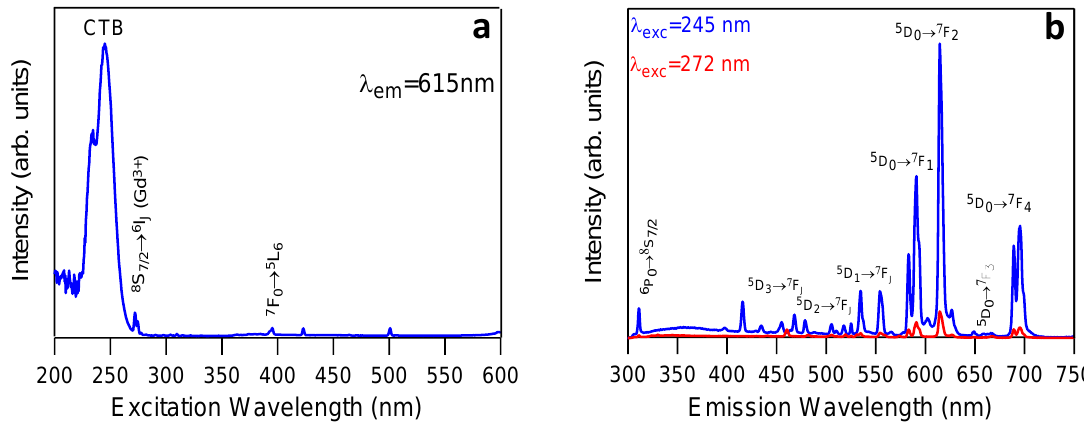
Figure 5. ( a ) Excitation spectrum of Eu 3+ and Gd 3+ ions from 1.5Eu 3+ : NaGdF 4 NPs heat-treated at 450 °C for 5 h, collecting the luminescence at 615 nm. ( b ) Emission spectra of Eu 3+ and Gd 3+ ions from 1.5Eu 3+ : NaGdF 4 NPs heat-treated at 450 °C for 5 h, excited at 245 nm (blue line) and 272 nm (red line).